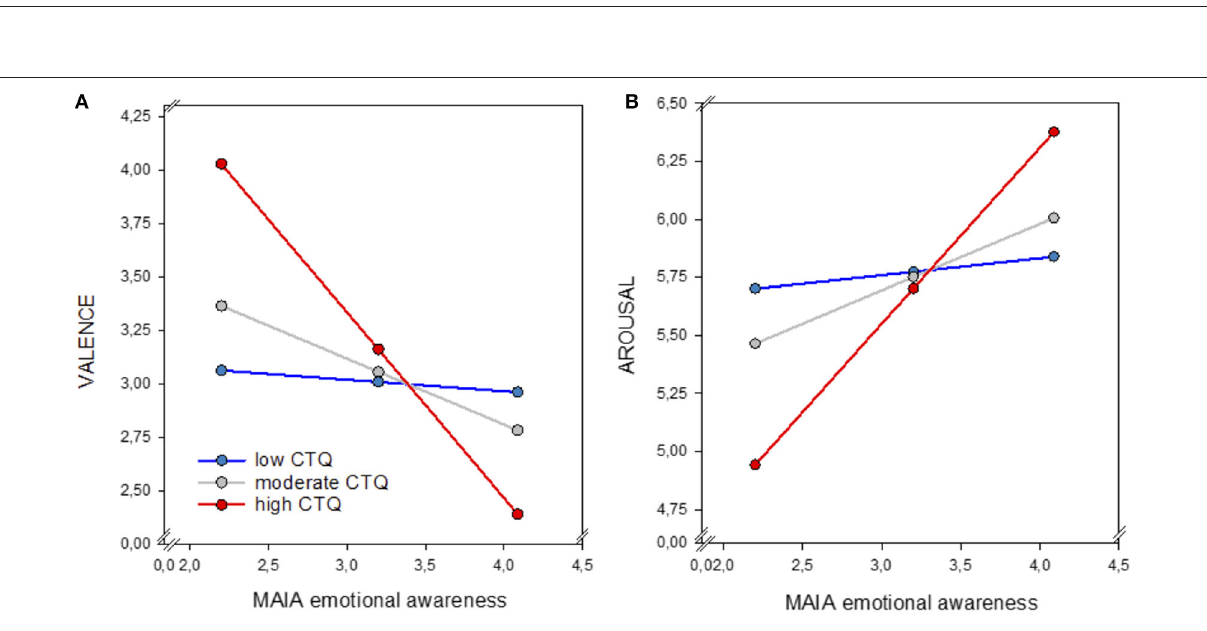
IBD group, however, this increase was less strong